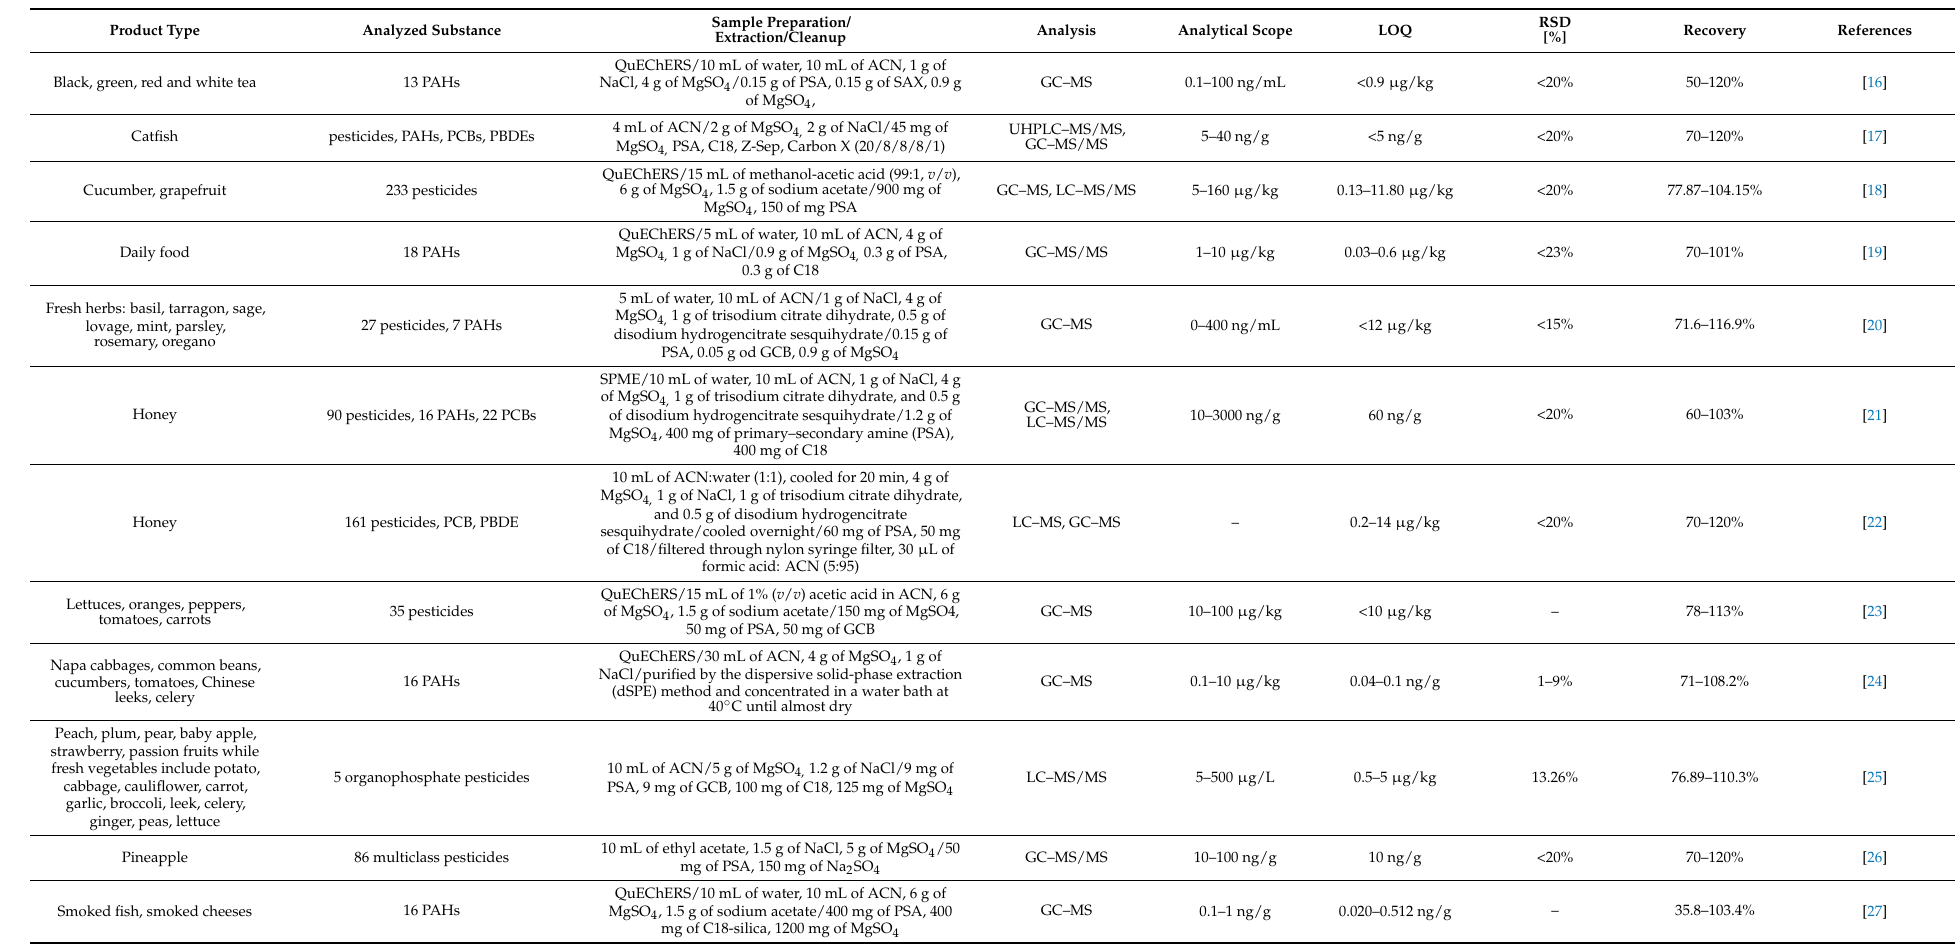
Table 1. Examples of methods application in pesticides and PAHs analysis from various sample